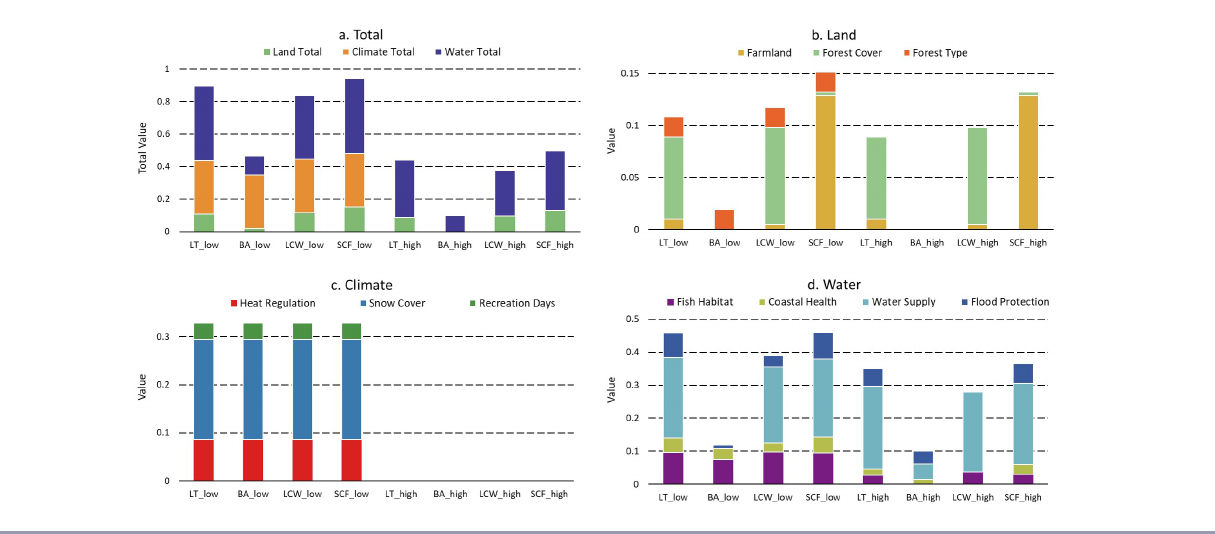
Fig. 3. Overall multiattribute social value of each scenario subdivided by domain (A), as well as the relative contribution of ecosystem services within each domain for land (B), climate (C) and water (D). The least desirable levels of each attribute have, by definition, zero contribution to multiattribute social value. Scenarios: low = low emissions, high = high emissions, acronyms defined in Table